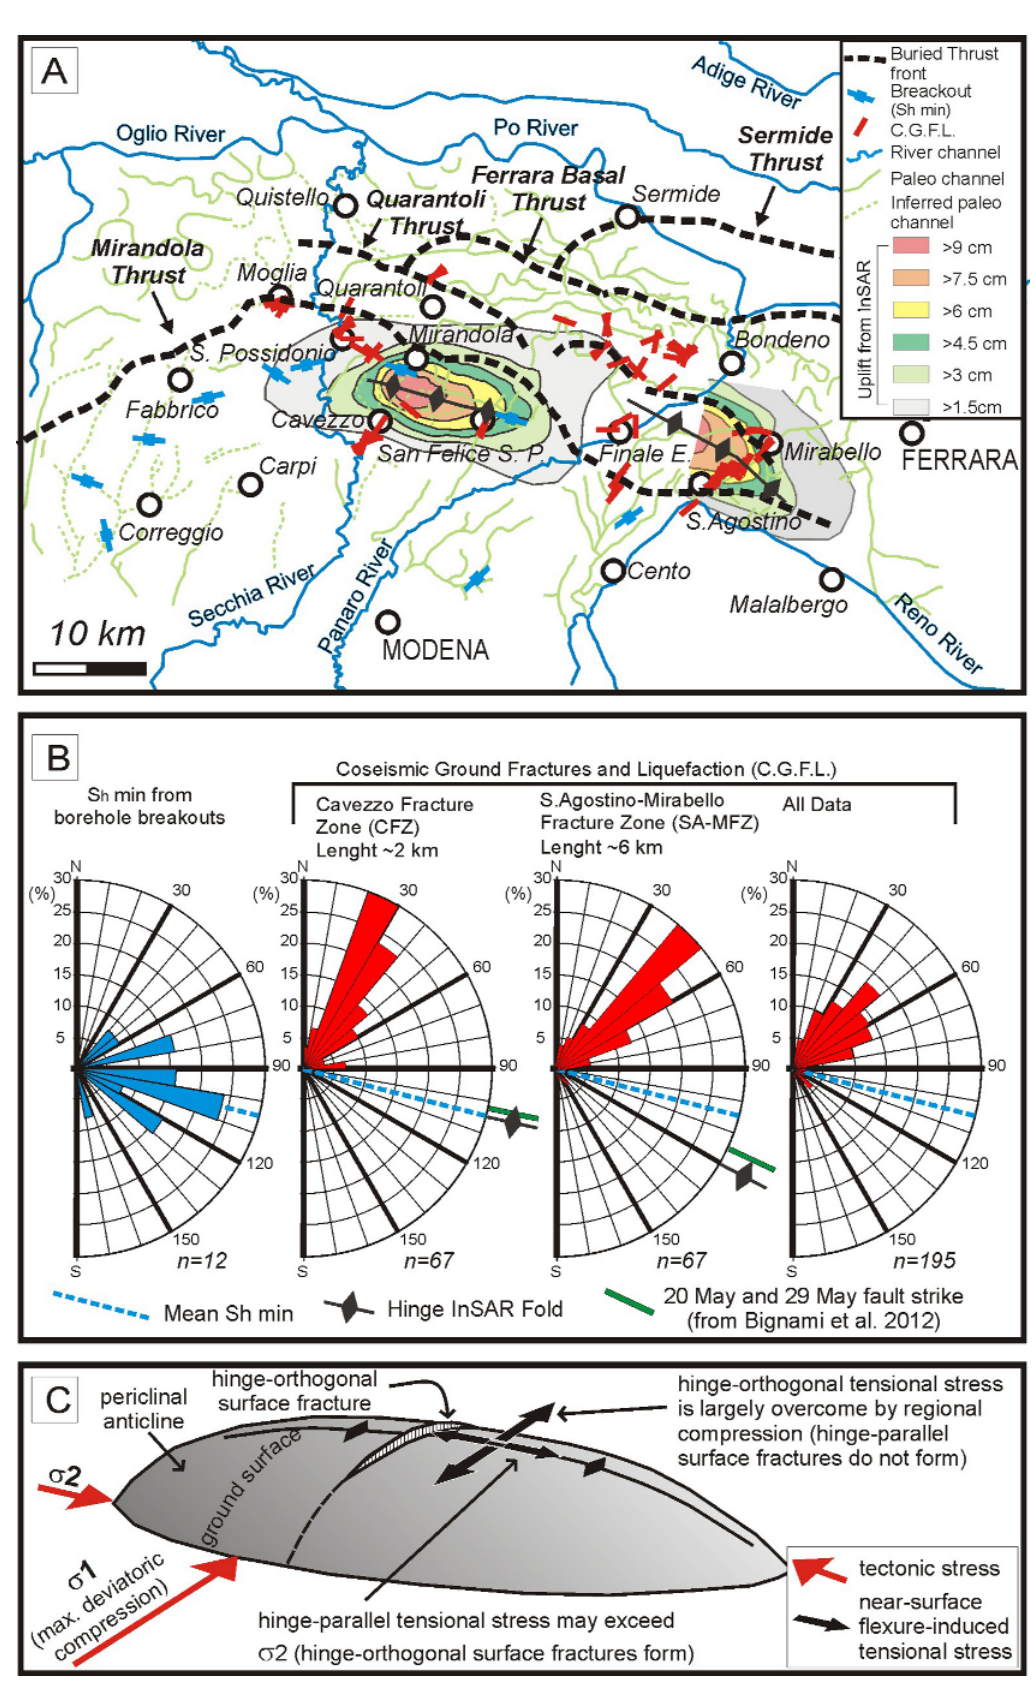
Figure 4. Map pattern (A) and rose diagrams (B) of the coseismic ground fractures and liquefaction surveyed soon after the May 20 and 29, 2012, events (our original field data are integrated with those from http://ambiente.regione.emilia-romagna.it/geologia/temi/sismica/liquefazione-gruppo-di-lavoro; and from http://www.eeecatalog.sinanet.apat.it/emilia/earthquake/index.php]. The river paleo-channels are from the Geological Map of the Emilia- Romagna Plain [Regione Emilia-Romagna, SELCA 1999]. (C) Possible interpretation of the major coseismic fractures in relation to the near-surface tectonic stresses caused by the